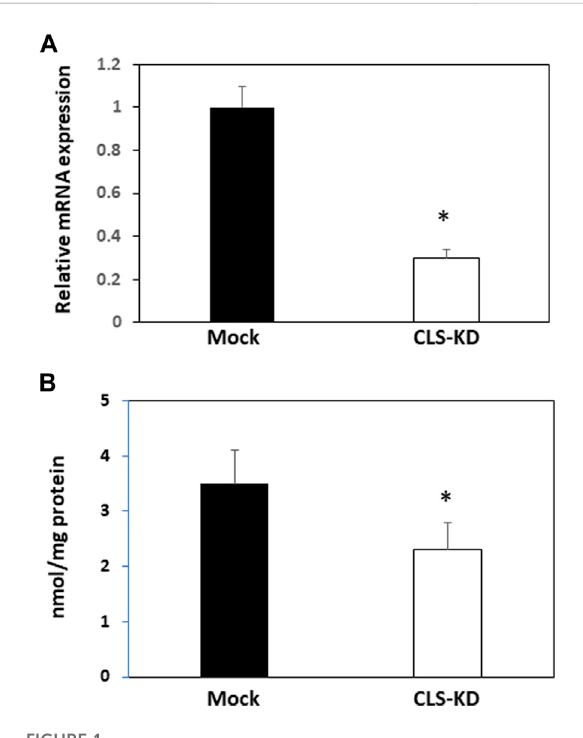
FIGURE 1 hCLS1 mRNA expression and CL levels in hCMEC/D3 cells transfected with hCLS1 siRNA. hCMEC/D3 cells were mock transfected or transfected with hCLS1 siRNA for 48 h and hCLS1 mRNA expression (A) or CL content (B) determined as described in Materials and Methods. n = 3 − 4, * p < 0.05.